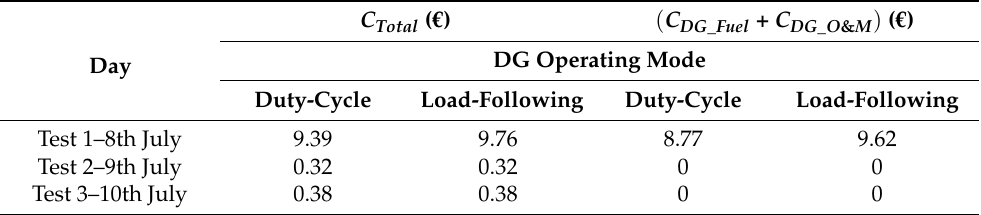
Table 4. Total energy cost of the DC microgrid under the different DG operating